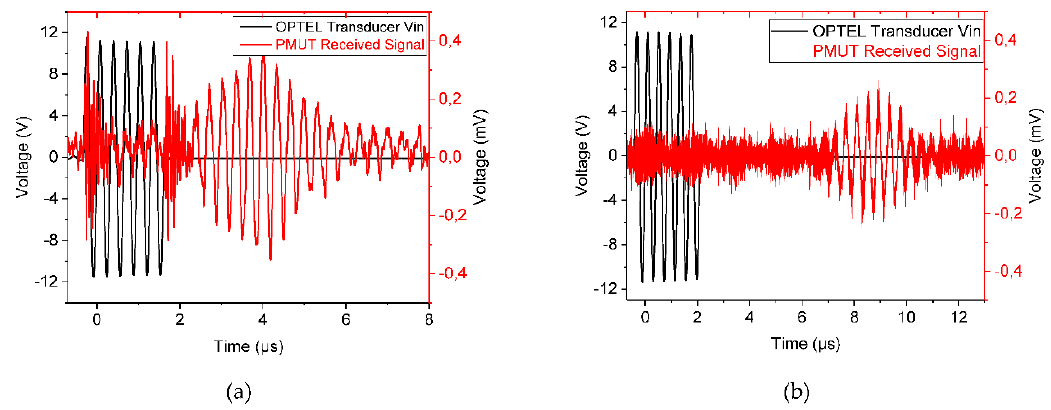
Figure 4. Measurement of PMUT response as sensor when an acoustic pressure is applied: ( a ) in H 2 O at 4.17 mm; ( b ) in FC-70 at 5.30